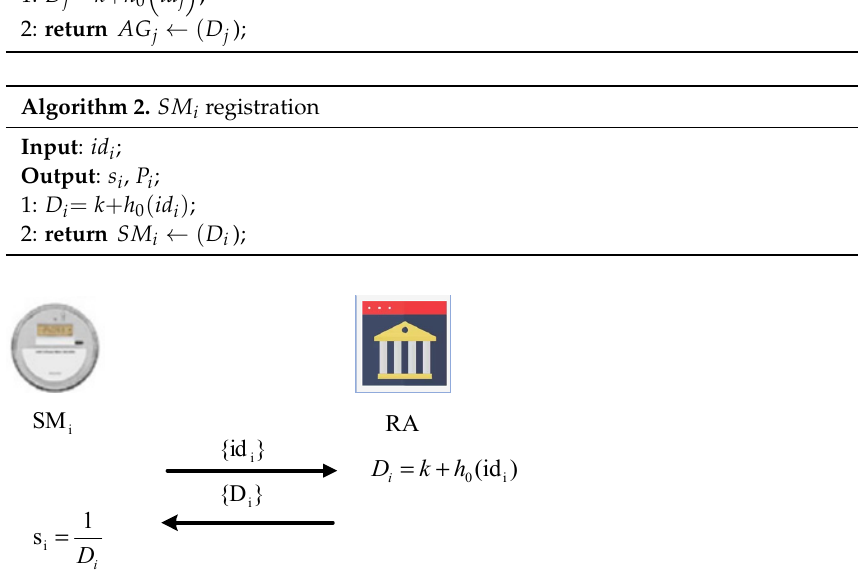
Figure 3. The process of SM i registration.